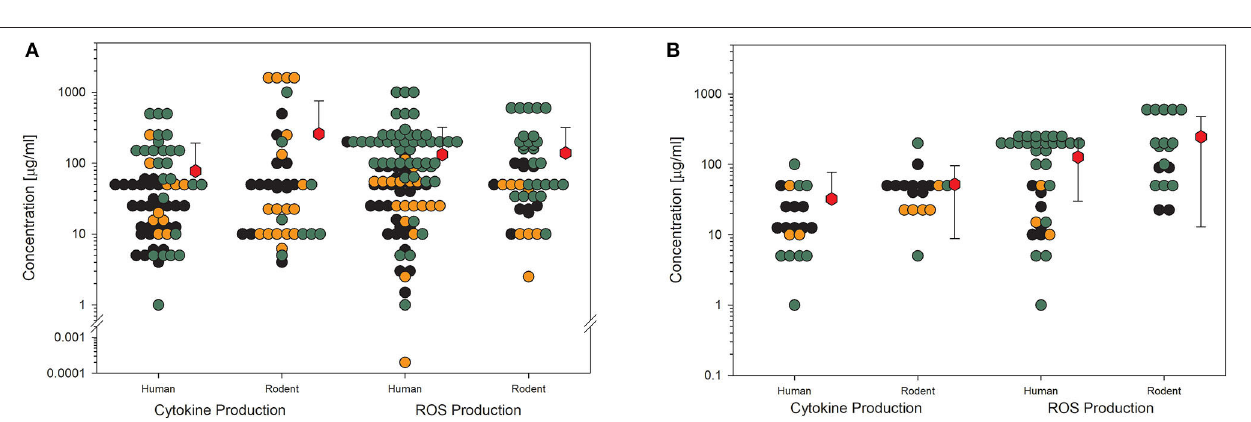
FIGURE 7 | Comparison of human and rodent cell lines in terms of their sensitivity to amorphous silica treatment. Datasets on the key events “cytokine production” and “ROS production” are shown. For this comparison, only data for particles with primary sizes below 100nm were included. Mean values are calculated from each dot cloud (red hexagons). (A) All available datasets; (B) datasets from studies with high-quality scores of 0.8 or 1. Details are as those shown in Figure 2 .